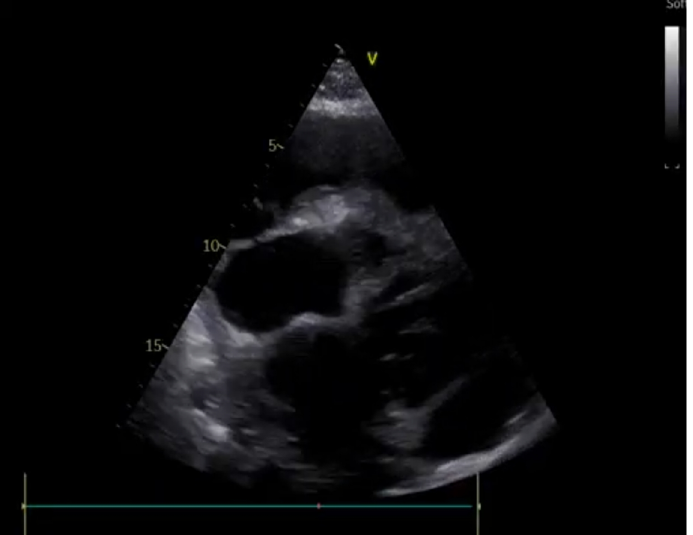
Figure 7. Pericardial tamponade: end-diastolic right ventricular chamber collapse is associated with significant pericardial effusion.